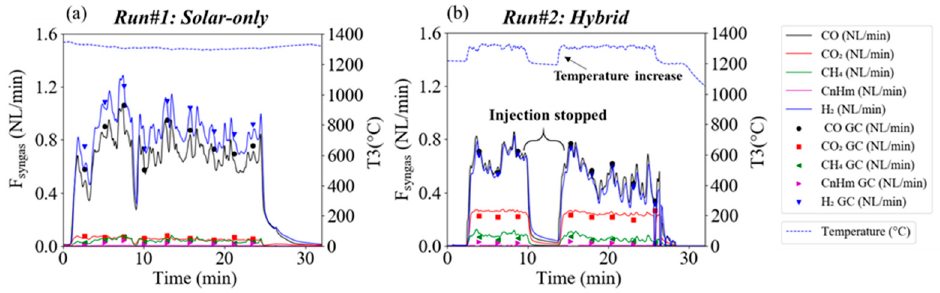
Figure 3. Syngas flow rates in ( a ) Run#1 (solar-only) and ( b ) Run#2 (hybrid) and T3 temperature evolution (in ◦